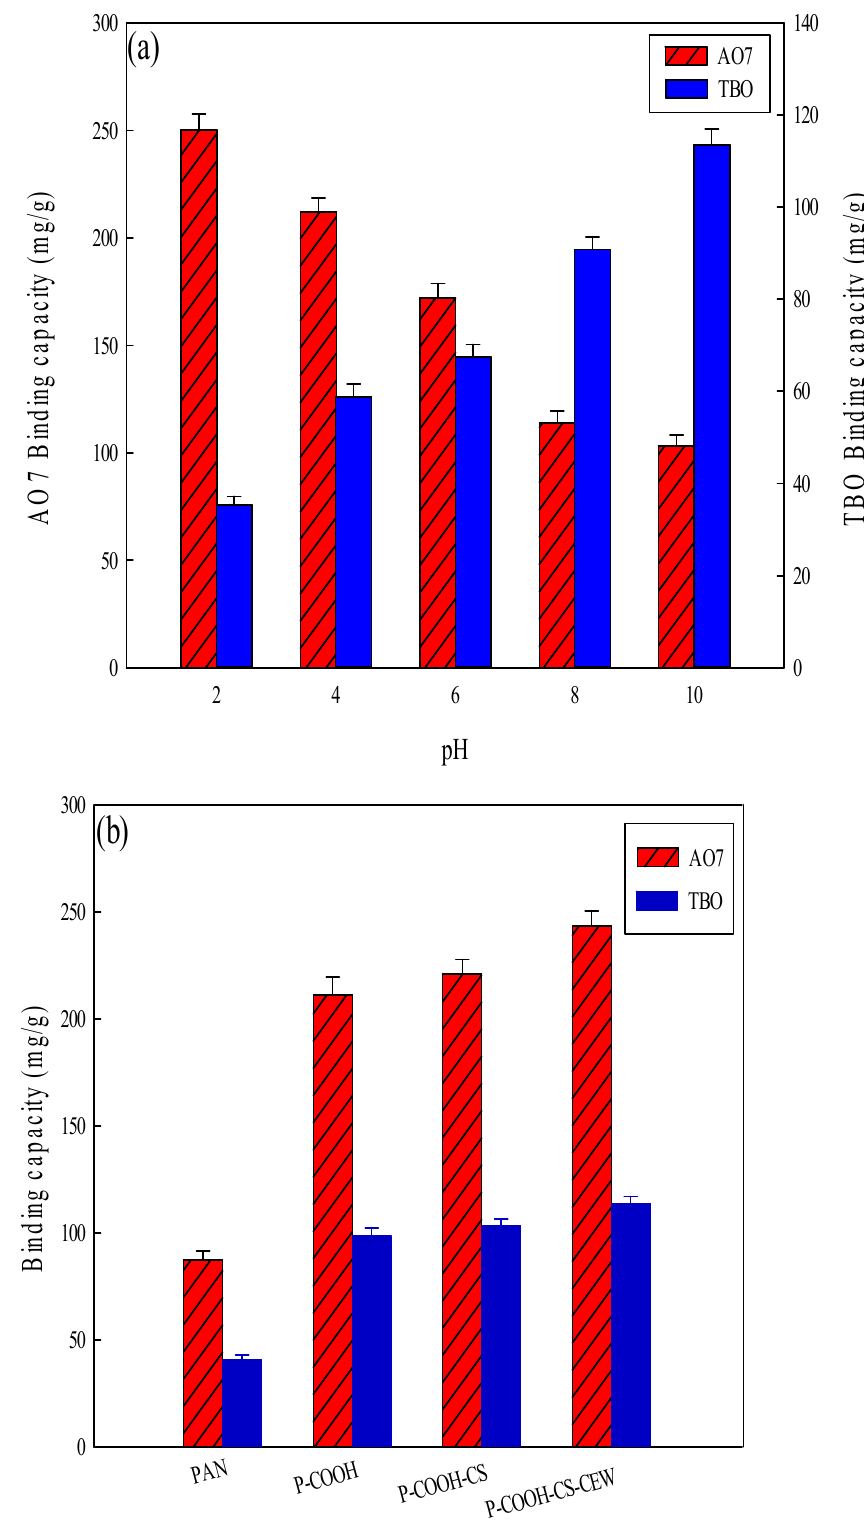
Figure 6. ( a ) Effect of buffer pH on the adsorption of AO7 and TBO on P-COOH-CS-CEW nanofiber membrane. ( b ) A comparison of binding capacity of different nanofiber membranes for AO7 and TBO dyes. Operating conditions: ~0.03 g of nanofiber membranes incubated in 5 mL of dye solution [1 mg/mL of AO7 (pH 2) or TBO (pH 10)] at 150 rpm and 25 °C for 3 h.